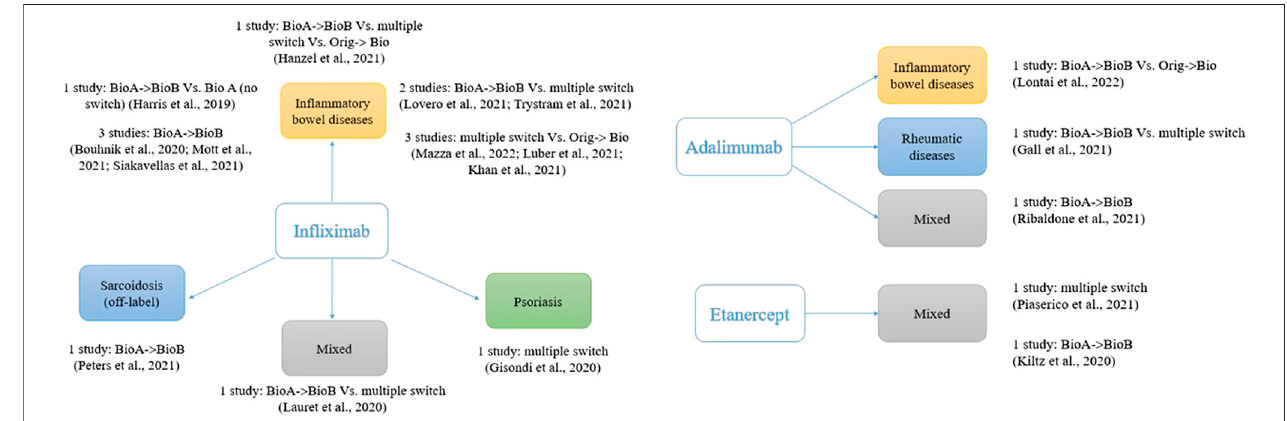
FIGURE 1 | Studies assessing switch between biosimilars of anti-TNF; one study with fi ve comparisons not included (Macaluso et al., 2021).